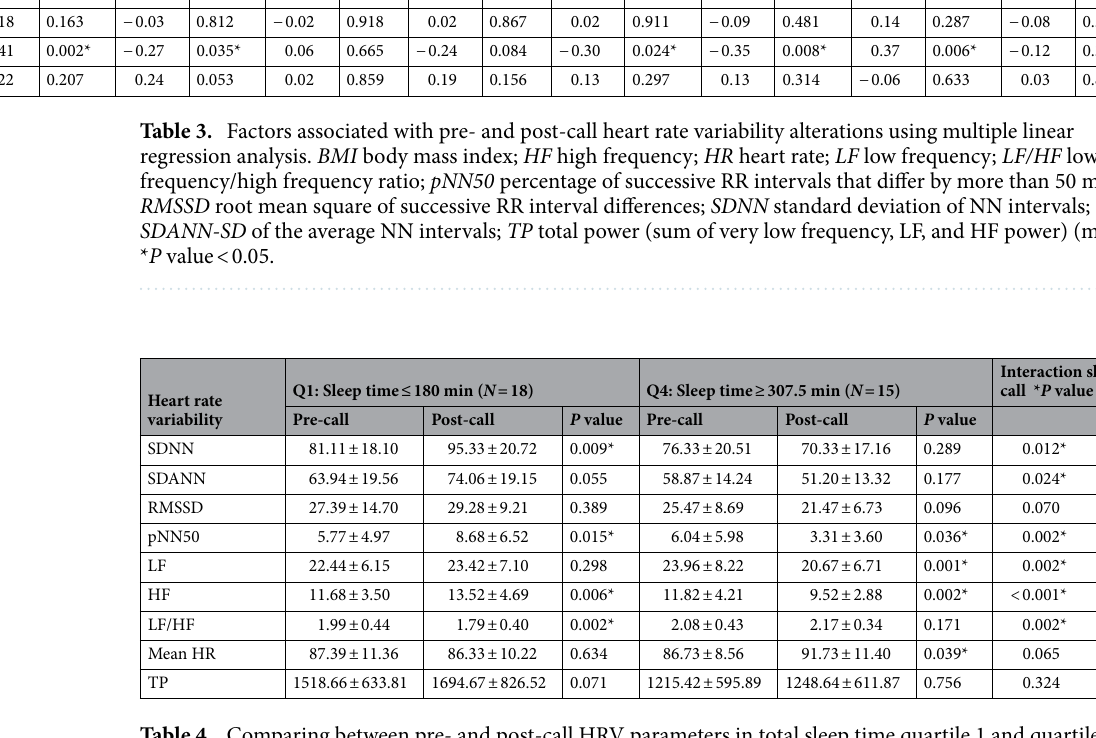
Table 4. Comparing between pre- and post-call HRV parameters in total sleep time quartile 1 and quartile 4 group. HR heart rate, HF high frequency, LF low frequency, pNN50 percentage of successive RR intervals that differ by more than 50 ms, Q-quartile, RMSSD root mean square of successive RR interval differences, SDNN standard deviation of NN intervals, SDANN-SD of the average NN interval; TP total power (sum of very low frequency, LF, and HF power) (ms 2 ). * P value <